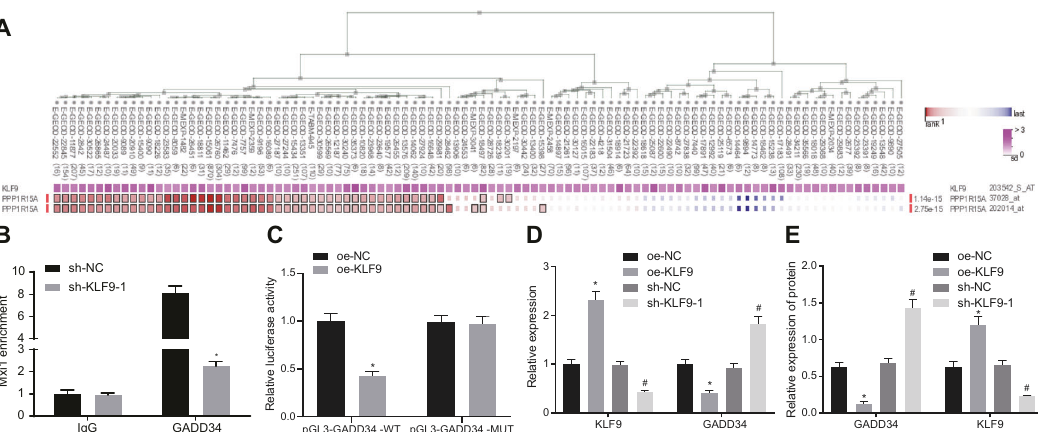
Fig. 6 KLF9 suppresses GADD34 expression by inhibiting its transcription. A The correlation between KLF9 and GADD34 in lung cancer analyzed by GEPIA database. B Result of ChIP assay indicating the enrichment of KLF9 at the promoter region of GADD34. * p < 0.05, vs. sh-NC. C Result of dual luciferase reporter assay demonstrating the interaction between KLF9 and the promoter region of GADD34 in HEK293 cells. * p < 0.05, vs. oe-NC; # p < 0.05, vs. sh-NC. D Result of RT-qPCR evaluating the mRNA expression of GADD34 in lung cancer cells with KLF9 overexpression or silencing. * p < 0.05, vs. oe-NC; # p < 0.05, vs. sh-NC. E Western blot analysis investigating the protein expression of GADD34 in A549 cells with KLF9 overexpression or depletion. * p < 0.05, vs. oe-NC; # p < 0.05, vs. sh-NC. Cell experiments were conducted three times